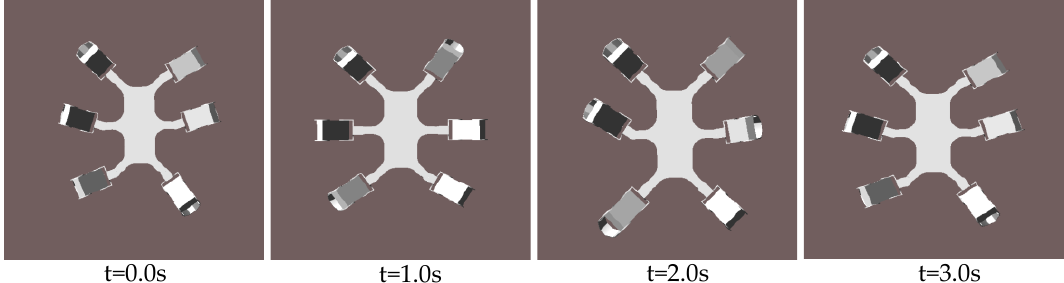
Figure 15. Lateral view of one period simulation sequence with leg 1 fault.